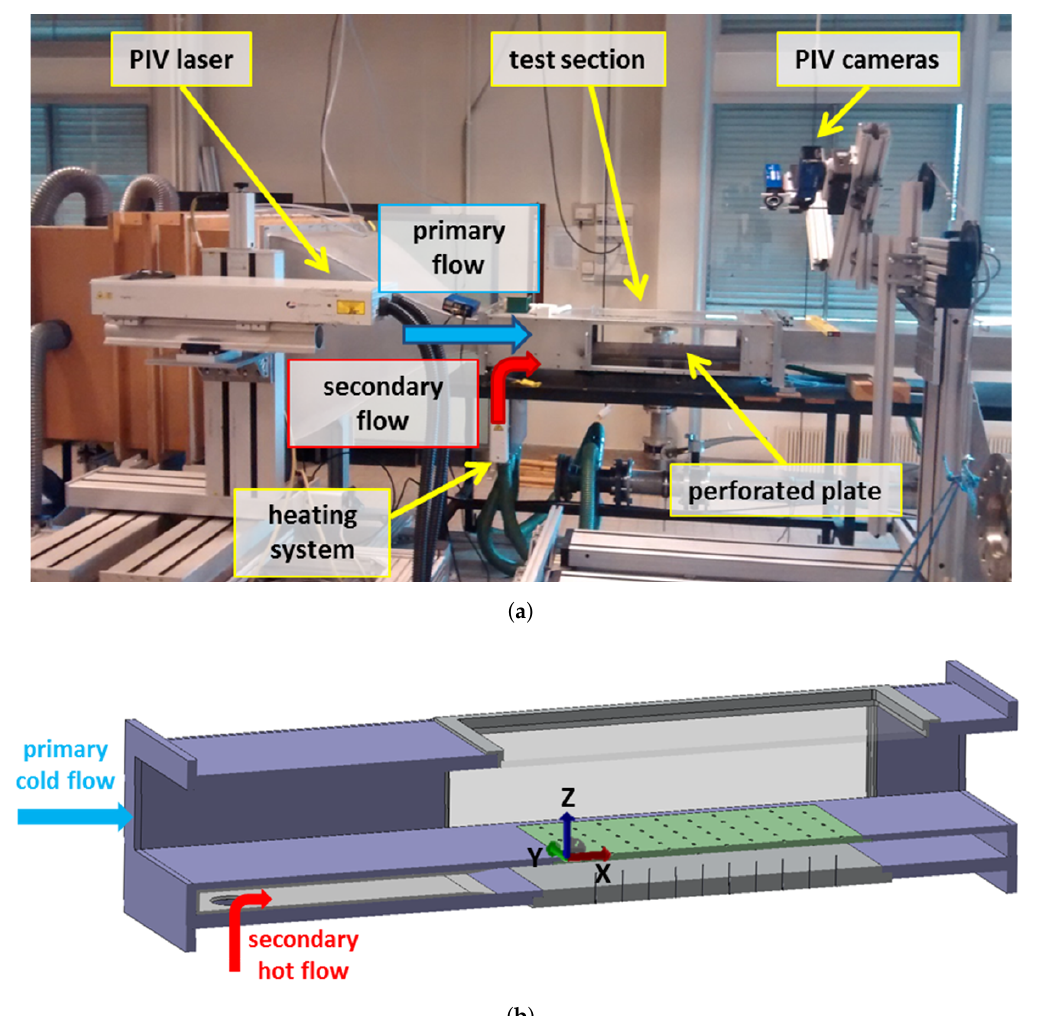
Figure 1. Set-up of the multiperforated plate experiment—In blue: main cold flow with a section of 448 × 135 mm 2 -In red: secondary hot flow with a section of 448 × 36 mm 2 . ( a ) Experimental apparatus with SPIV set-up for Z-plane acquisition; ( b ) Close-up view of the test section—Definition of the referential frame linked to the wind tunnel—The direction of the main flow is defined by X